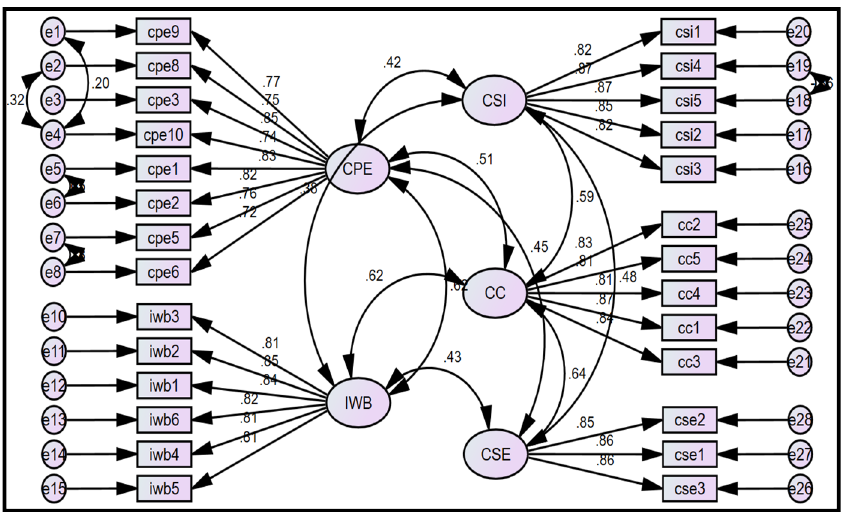
Figure 1. Confirmatory factor